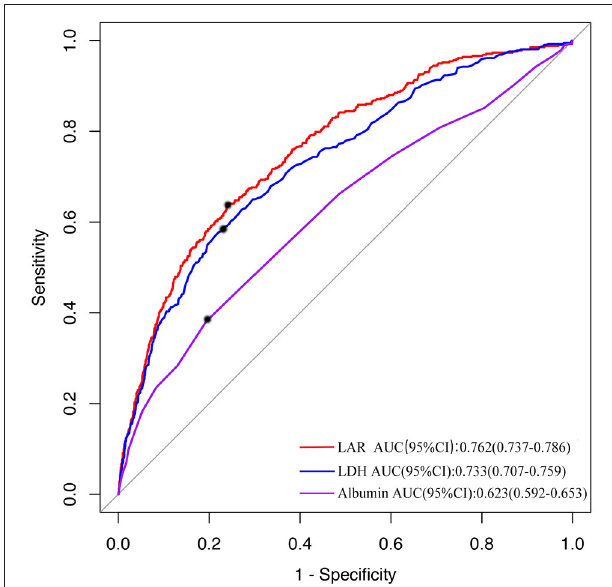
FIGURE 4 | Association between LAR and risk of SAP using restricted cubic spline (RCS) analysis. Risk of developing SAP in AIS patients increased with advanced LAR. When the value of LAR ranged from 6–10, the risk of SAP increased rapidly with the elevation of LAR. While, the risk of SAP was relatively stable, with the value of LAR < 6 or > 10. SAP, stroke-associated pneumonia; OR, odds ratio; 95%CI, 95% confidence interval.